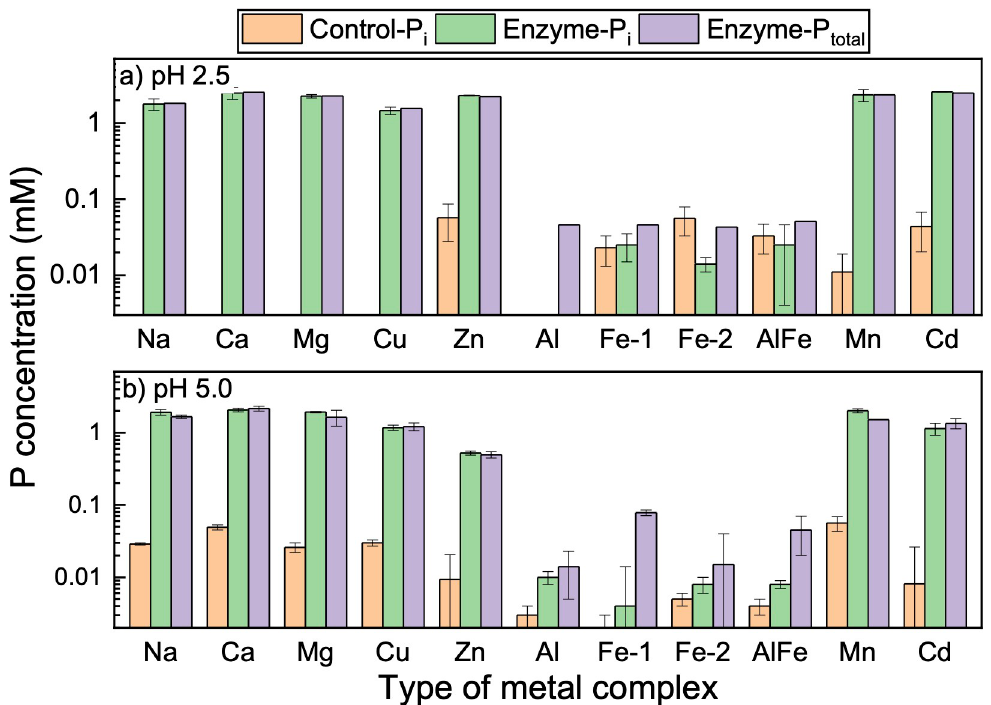
Fig 6. Released inorganic P in phytate metal complexes (2 mM P) after 20 h incubation with Aspergillus enzyme at pH 2.5 and 5.0. Control refers to treatment without the enzyme. For enzymatic treatments, 0.1 U/mL Aspergillus phytase was used.